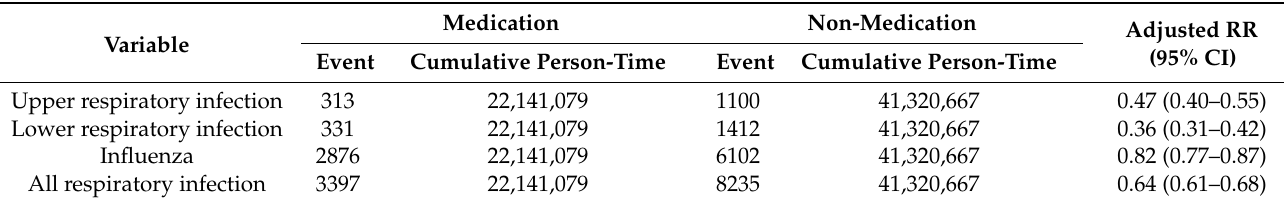
Table 3. Self-controlled case series analysis of the risks of respiratory infection on the basis of methylphenidate treatment in children with attention-deficit/hyperactivity disorder. Medication Non-Medication Adjusted RR Variable